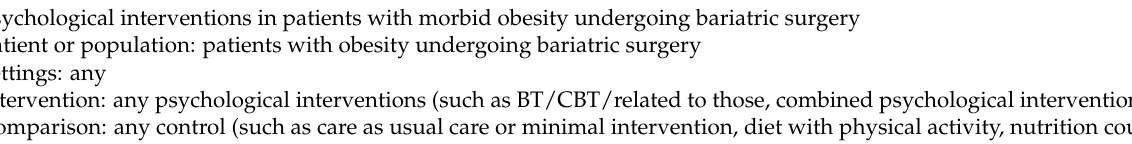
Table 2. Summary of findings